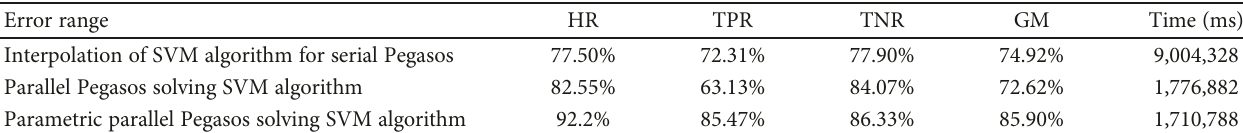
Table 4: Summarization of statistical results of [Si]% lifting dynamic prediction performance of three di ff erent algorithms.